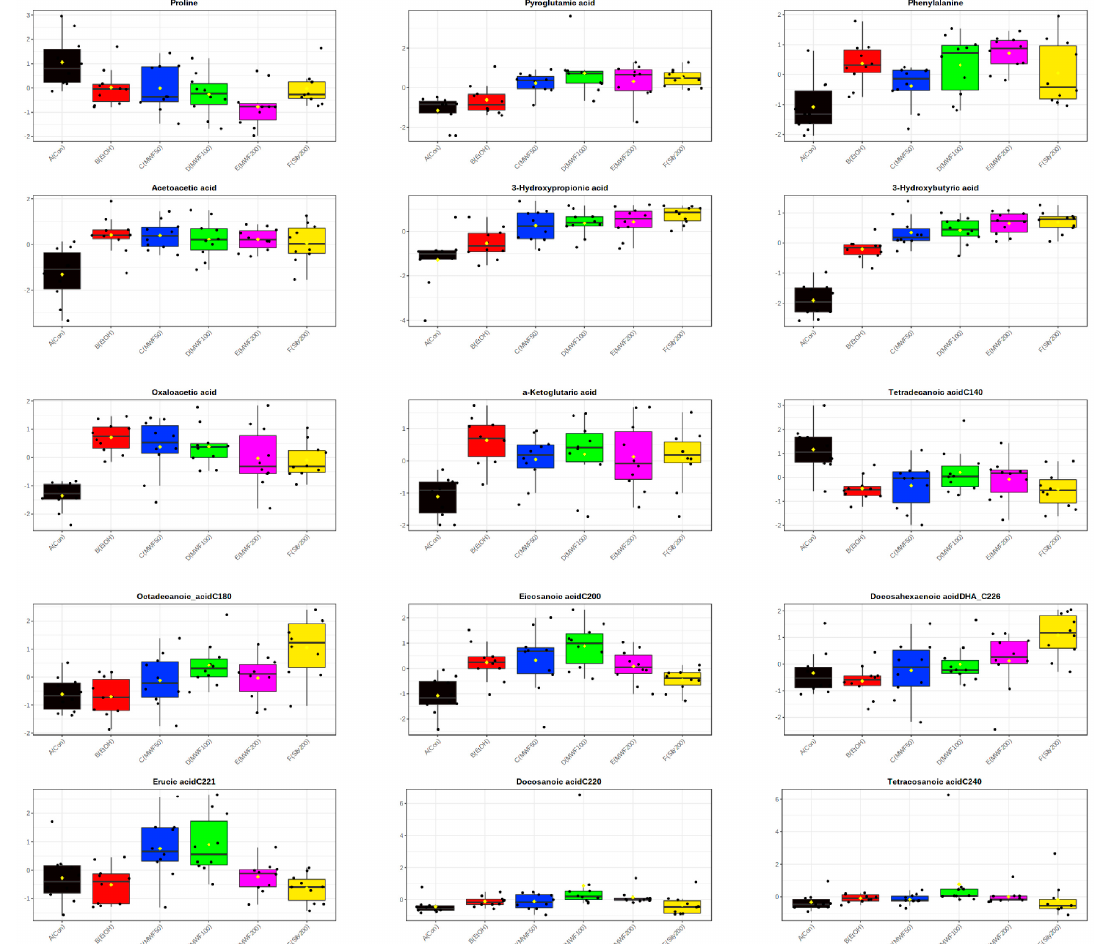
Figure 1. Box plots of 15 significant metabolites in ANOVA.